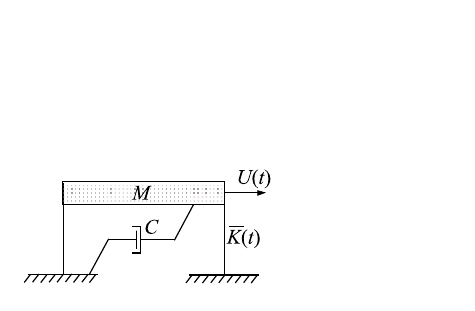
Fig. 3. Inelastic single degree-of-freedom system. Fig. 4. Elastic three degree-of-freedom